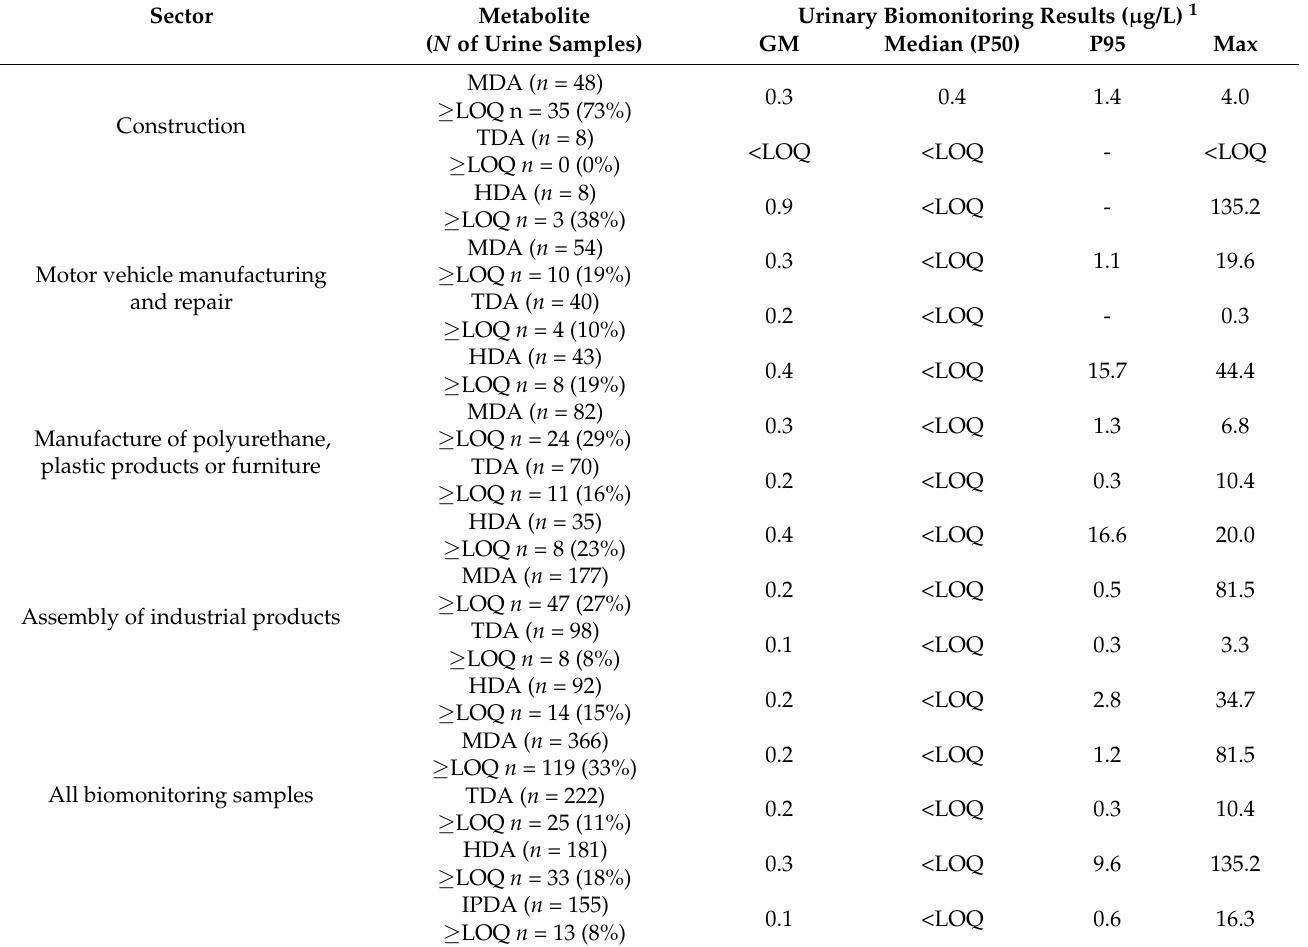
Table 4. Human biomonitoring data on diisocyanates for specific sectors from Finnish occupational studies in